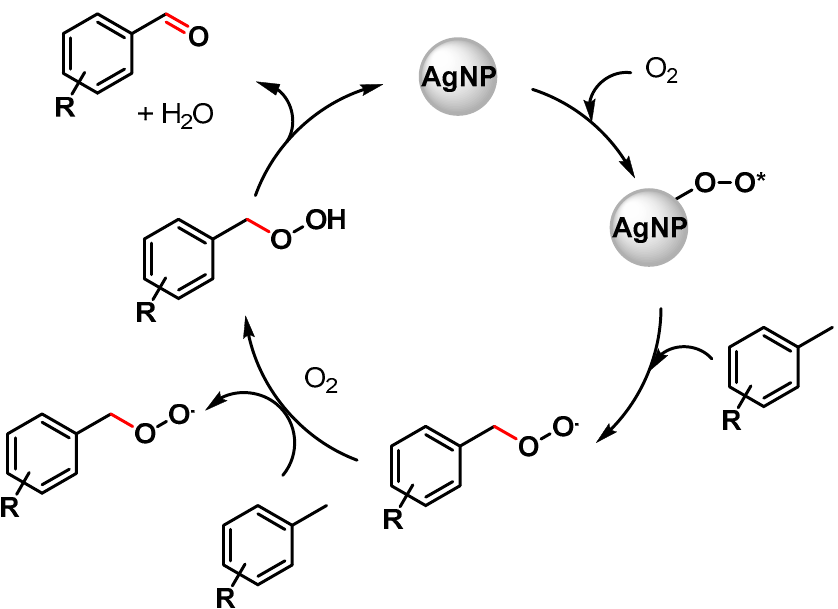
Scheme 6. Proposed mechanism for C(sp3)–H bond activation of toluene with